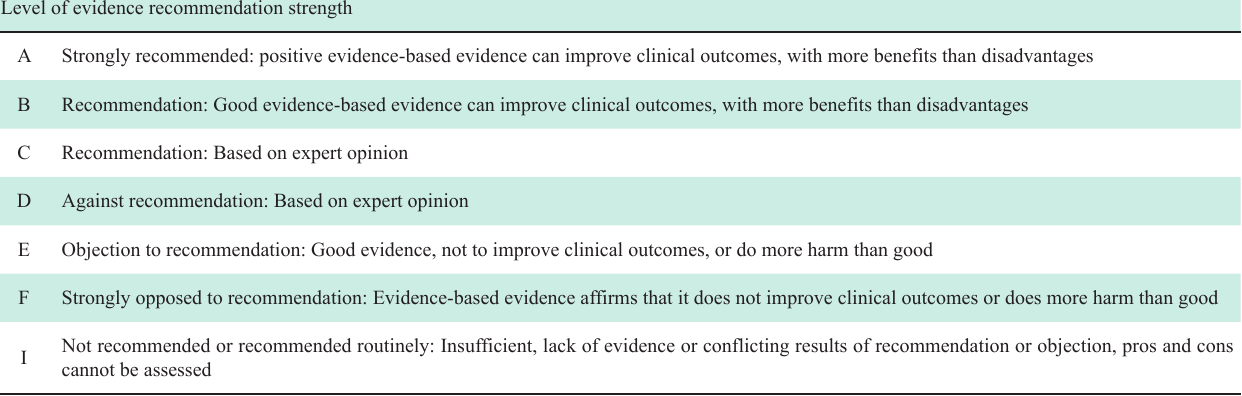
Table 1 Evidence level and recommended strength Level of evidence recommendation